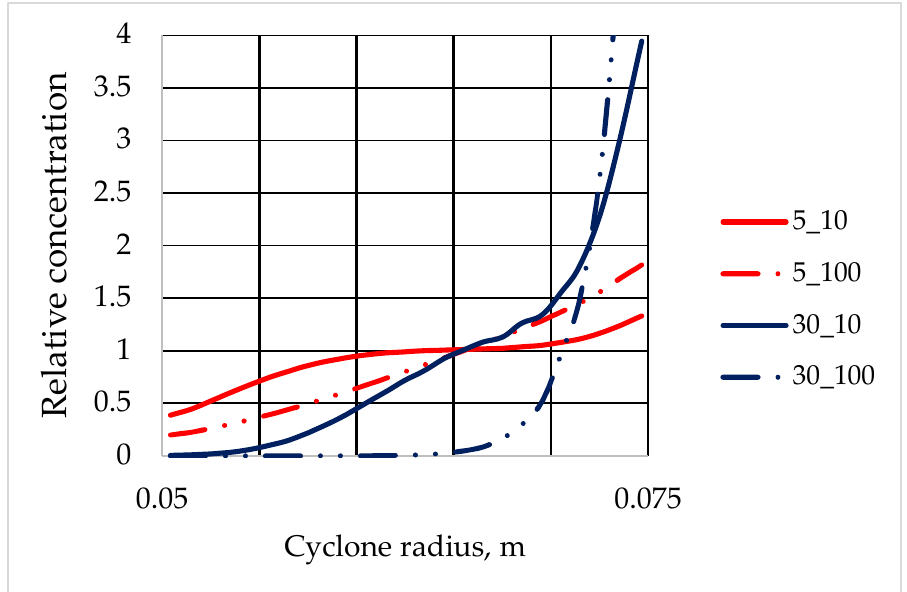
Figure 4. Relative concentration profiles of N/N in particles in different sections of the separation chamber. Solid line: distance to the swirler was 10 mm; dotted line: distance to the swirler was 100 mm.